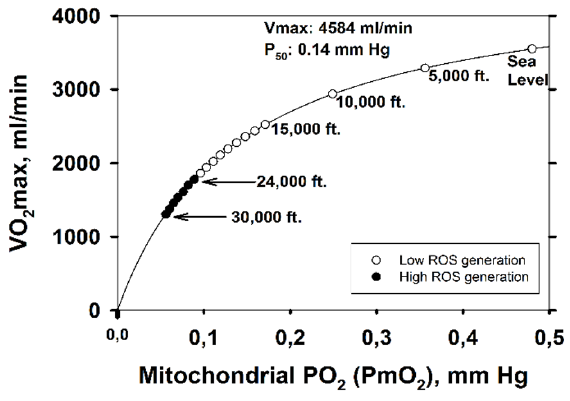
Figure 3. Reduction of maximal _ VV O and mitochondrial Po 2 in a 2 homogeneous muscle as a function of altitude, (solid line, computed from the O 2 pathway model) and degree of ROS generation as a function of mitochondrial Po 2 (computed from the mitochondrial respiration model). Below 24,000 ft, ROS production is low (open circles), but above 24,000 ft, ROS production abruptly increases (closed circles).